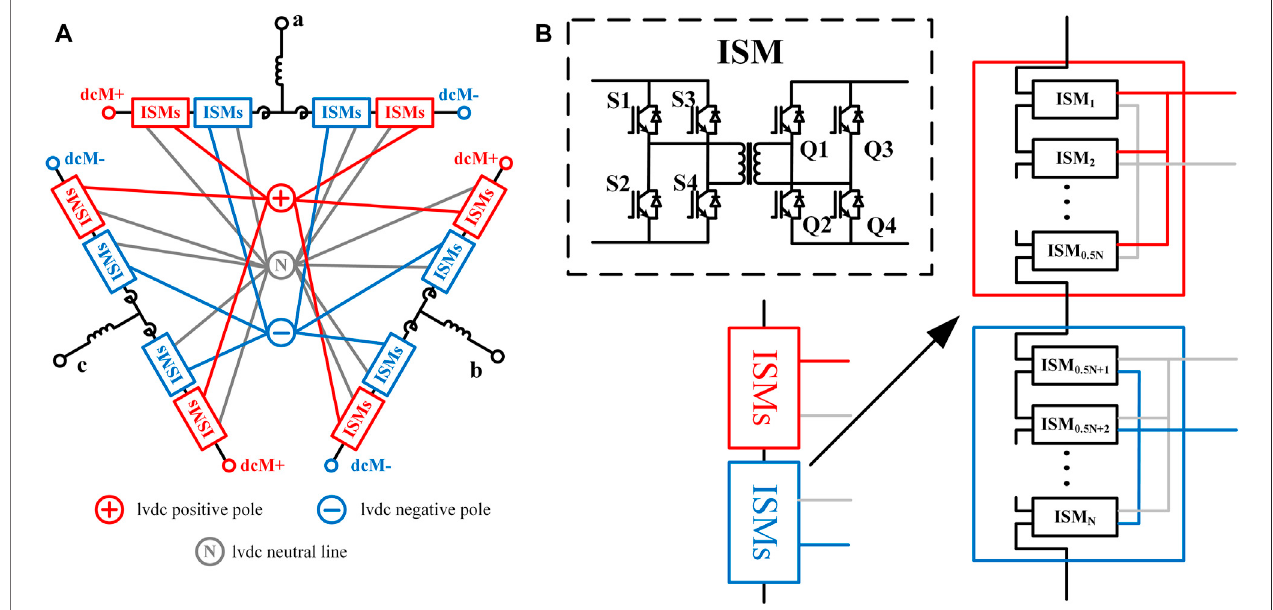
FIGURE 3 | (A) Topology diagram of the I-M 2 C. (B) Topology diagram of an upper arm.